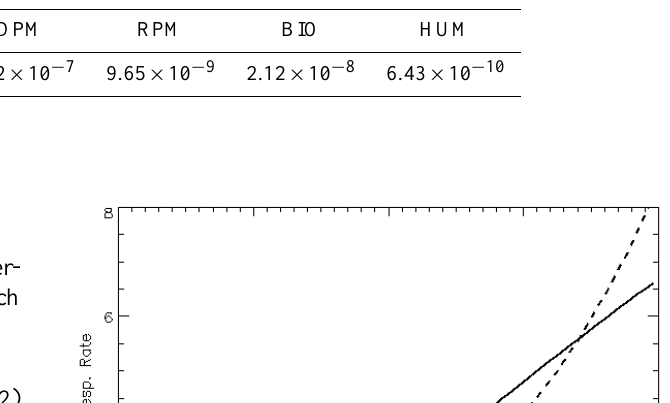
Table 8. Default values of pool-specific parameters for soil carbon. The pools are decomposable and resistant plant material (DPM, RPM), biomass (BIO) and humus (HUM).